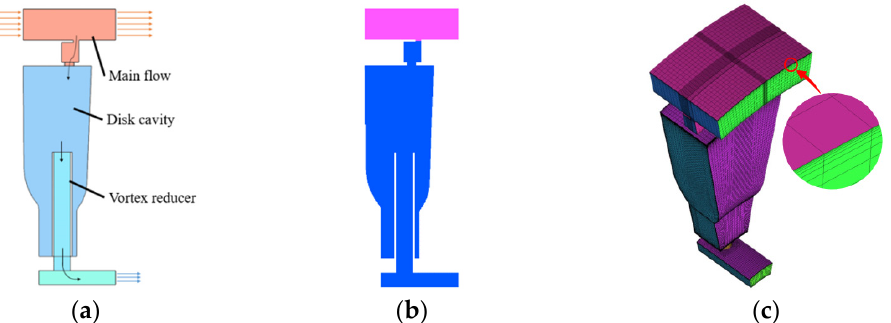
Figure 2. Modal shapes of the first eight modes: ( a ) First mode; ( b ) Second mode; ( c ) Third mode; ( d ) Fourth mode; ( e ) Fifth mode; ( f ) Sixth mode; ( g ) Seventh mode; ( h ) Eighth mode.